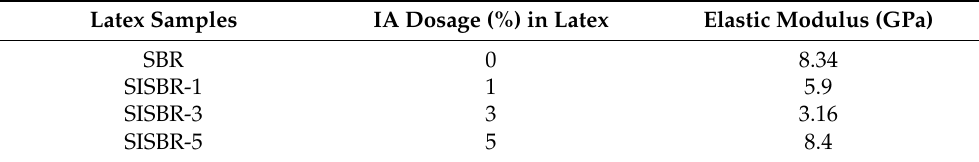
Table 2. Comparison of elastic